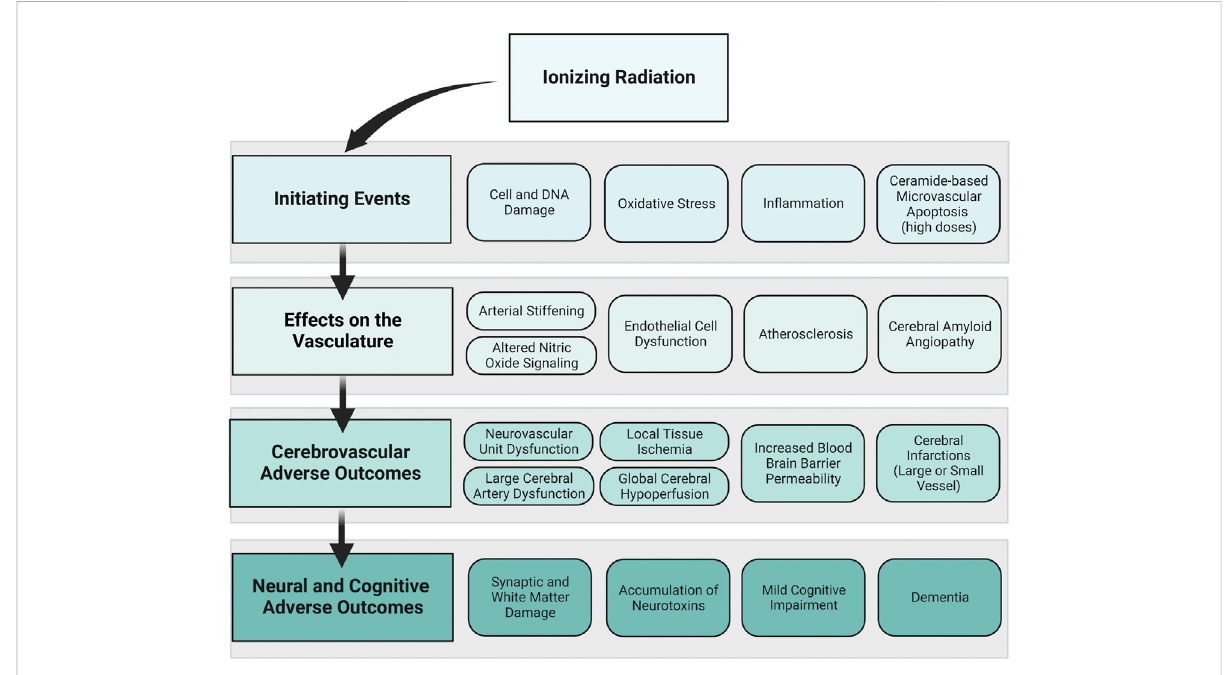
FIGURE 4 Proposed framework: ionizing radiation to neural and cognitive adverse outcomes via vascular mechanisms. How ionizing radiation may ultimately lead to neural and cognitive adverse outcomes through vascular mechanisms is displayed in this framework. The primary framework is displayed in the left column, where ionizing radiation creates initiating events that affect the vasculature, leading to cerebrovascular adverse outcomes and neural and cognitive adverse outcomes. To the right of each component of the primary framework, examples of individual events that may occur based on the data from the preclinical and human evidence base are shown. The order of boxes does not represent theorder of events, and the time course and probability of these events are unknown. Image created with